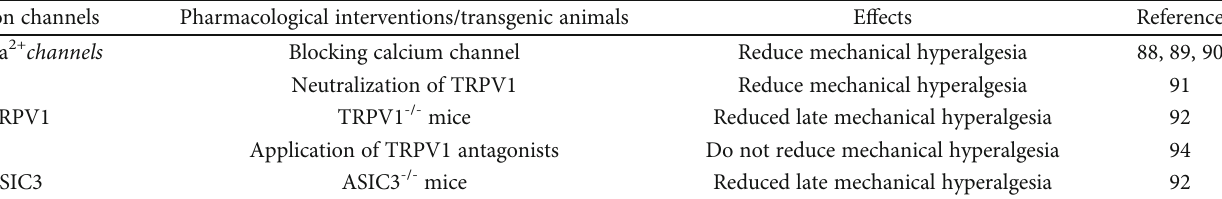
Table 2: Summarized studies showing the dual role of ion channels in RA